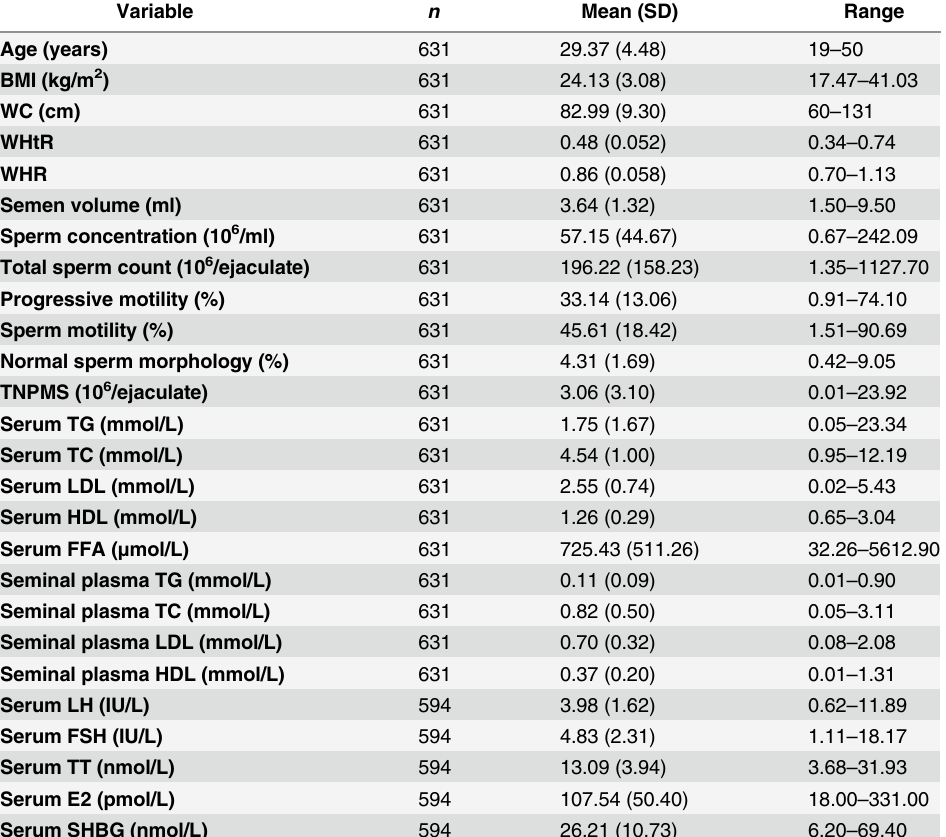
Table 1. Mean and range of age, obesity-associated markers, serum and seminal plasma lipids levels, serum reproductive hormones levels and semen parameters in 631 subfertile men.